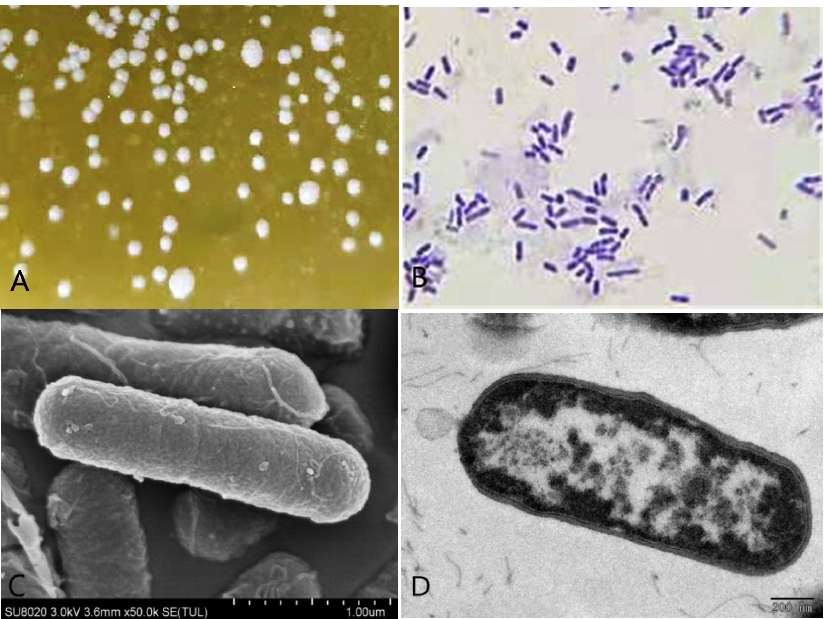
Figure 3. Morphological identification of the L. agilis WWK129 strain. ( A ) The colony characteristics of this strain; ( B ) the microstructure characteristics of this strain at 1000 magnification; ( C ) the scan-